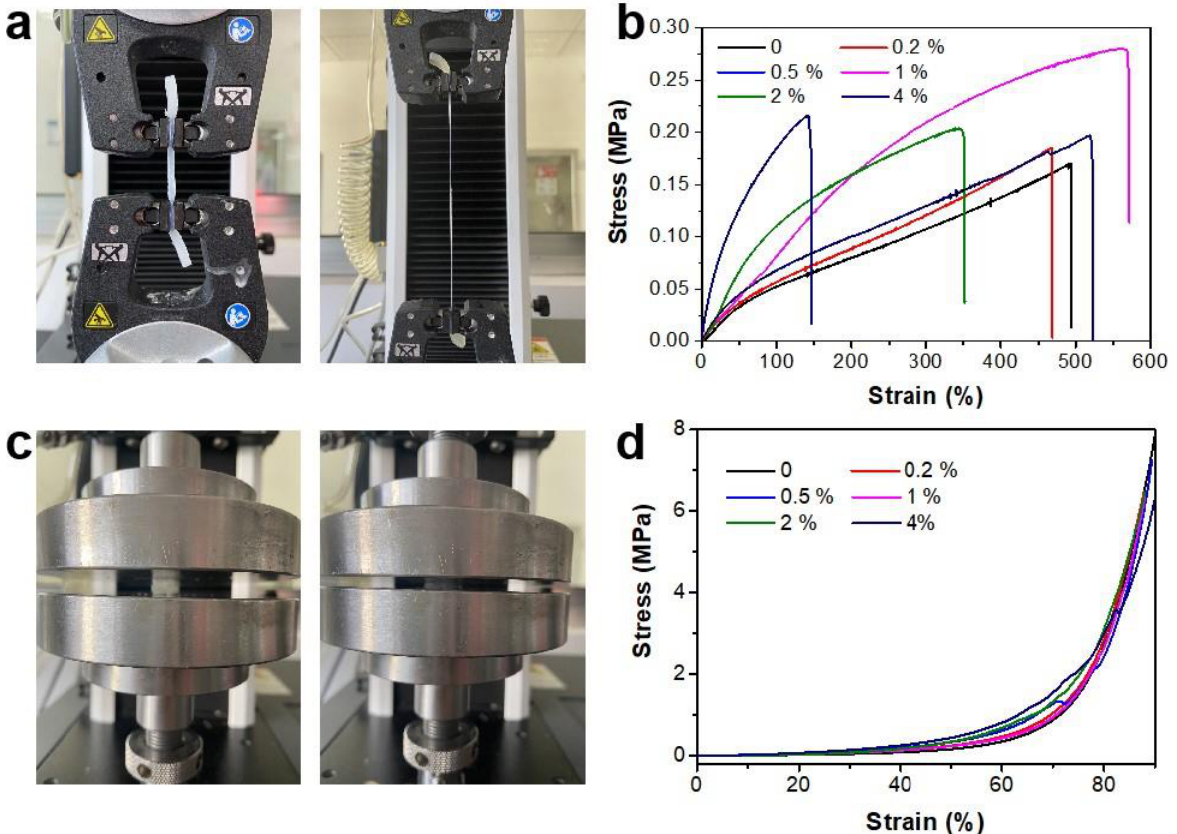
Figure 2. Photograph and stress-strain curves of the PAA/FF gels: ( a , b ) tensile and ( c , d ) compression with different amounts of Fmoc-FF (wt%).